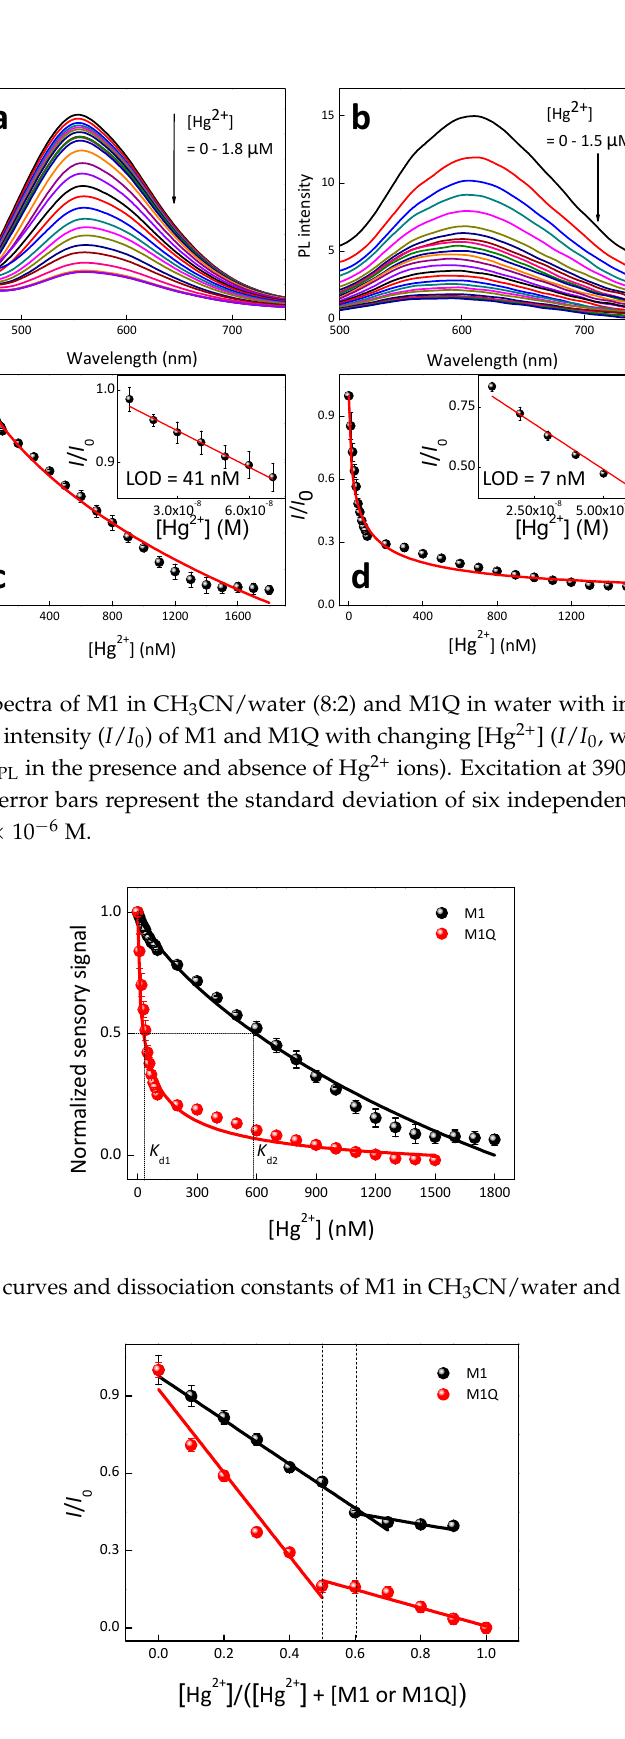
Figure 4. Job plots of M1 in CH 3 CN/water and M1Q in water.